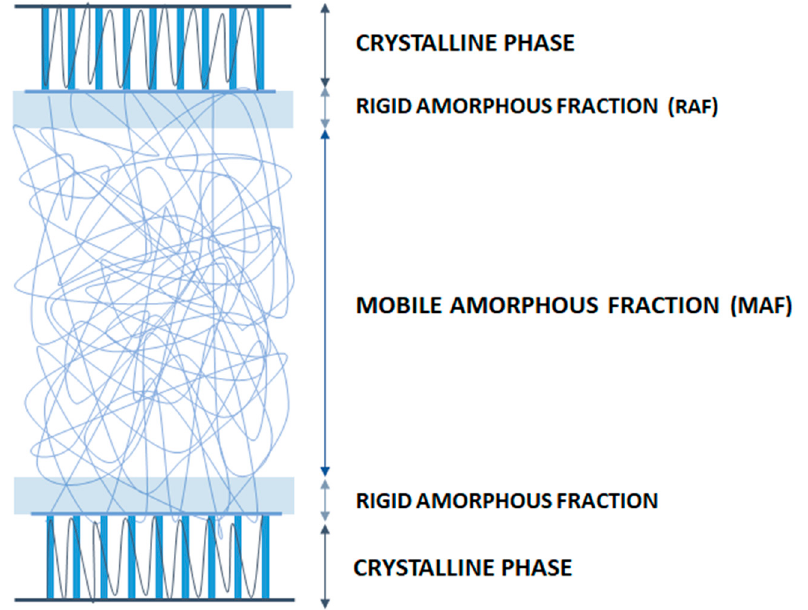
Figure 3. Schematic representation of the arrangement of crystalline, rigid amorphous and mobile amorphous fractions.